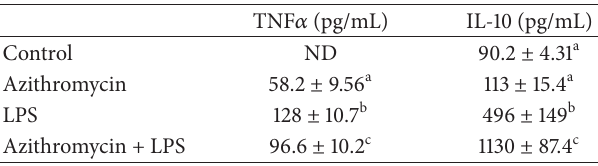
Table 2: TNF 𝛼 and IL-10 levels of